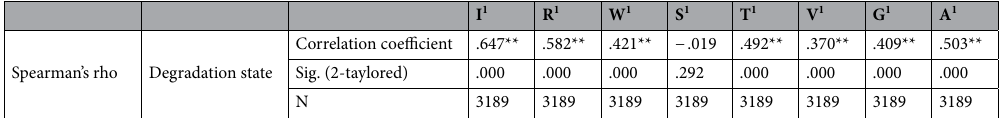
Table 1. Correlation between Degradation state and component indices of the WRASTIC-HI index. 1 I = industrial activities; R = recreational activities; W = waste waters; S = size of watershed; T = ways of transportation; V = vegetation; G = irrigation; A = agricultural activities; *Correlation is significant at the 0.05 level (2-tailed), **Correlation is significant at the 0.01 level (2-tailed).